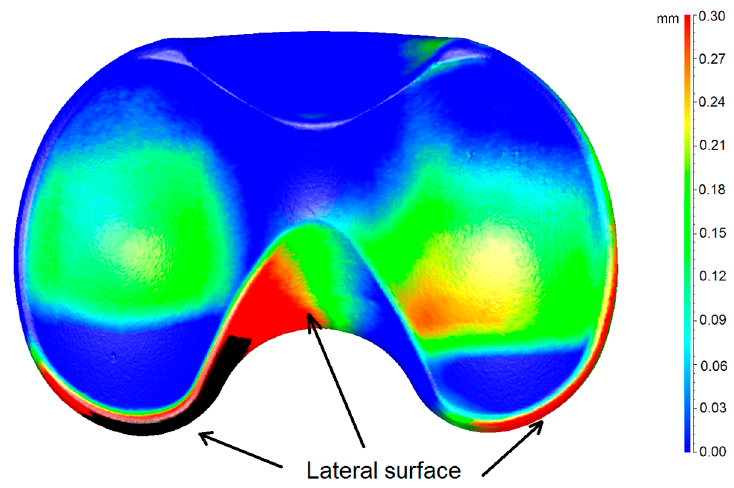
Figure 5. 3D wear map of the TKP mobile meniscus #1.